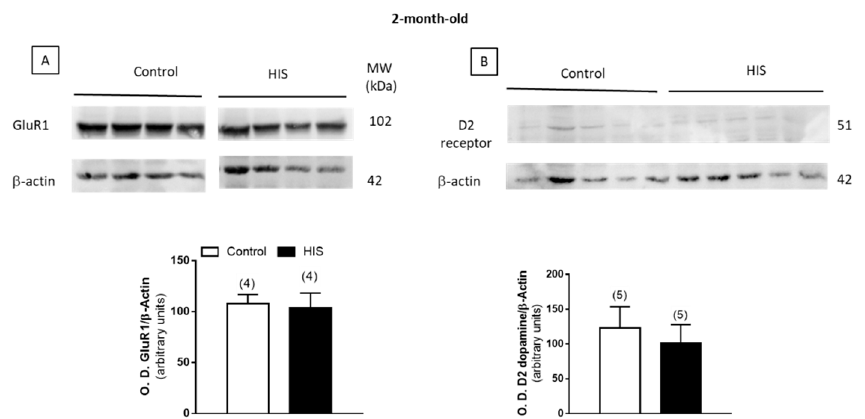
Figure 10. Immunoblotting analysis of alpha subunit of GluR1 ( A ) and dopamine D 2 receptor ( B ) subunits in cortical plasma membranes from 2-month-old rats. Plasma membranes (40 µ g) were subjected to SDS-PAGE, electrophoretically transferred to nitrocellulose and probed with recombinant anti-Glutamate Receptor 1 antibody and anti-Dopamine D 2 receptor antibody antisera, as described in Materials and Methods. Data, expressed as arbitrary units, are means ± SEM of experiments performed with five different plasma membrane preparations (Supplementary Materials: Figures S15–S18).